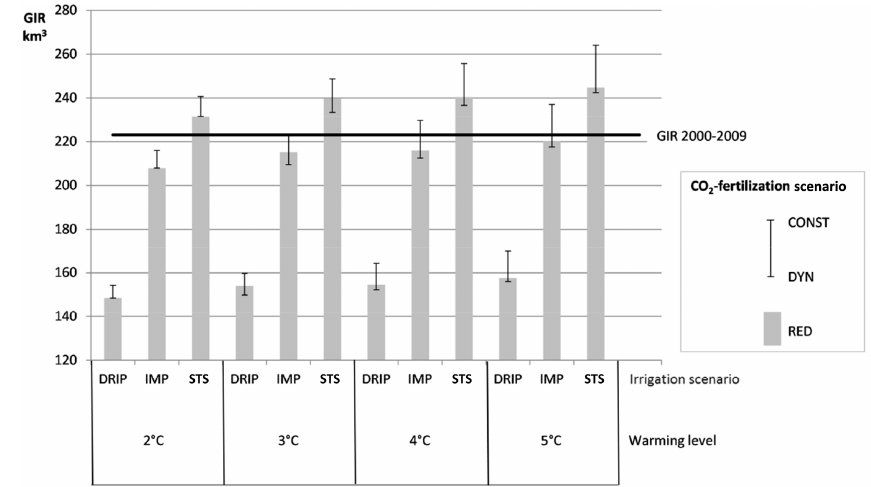
Figure 3. Median (19 GCMs) of gross irrigation water requirements (GIR) for four warming levels, three irrigation scenarios (STS, IMP, DRIP) and three CO 2 scenarios (column represents RED and whiskers represent DYN and CONST). The period 2080–2090 for the whole Mediterranean region is shown. Note that the x axis starts at 120km 3